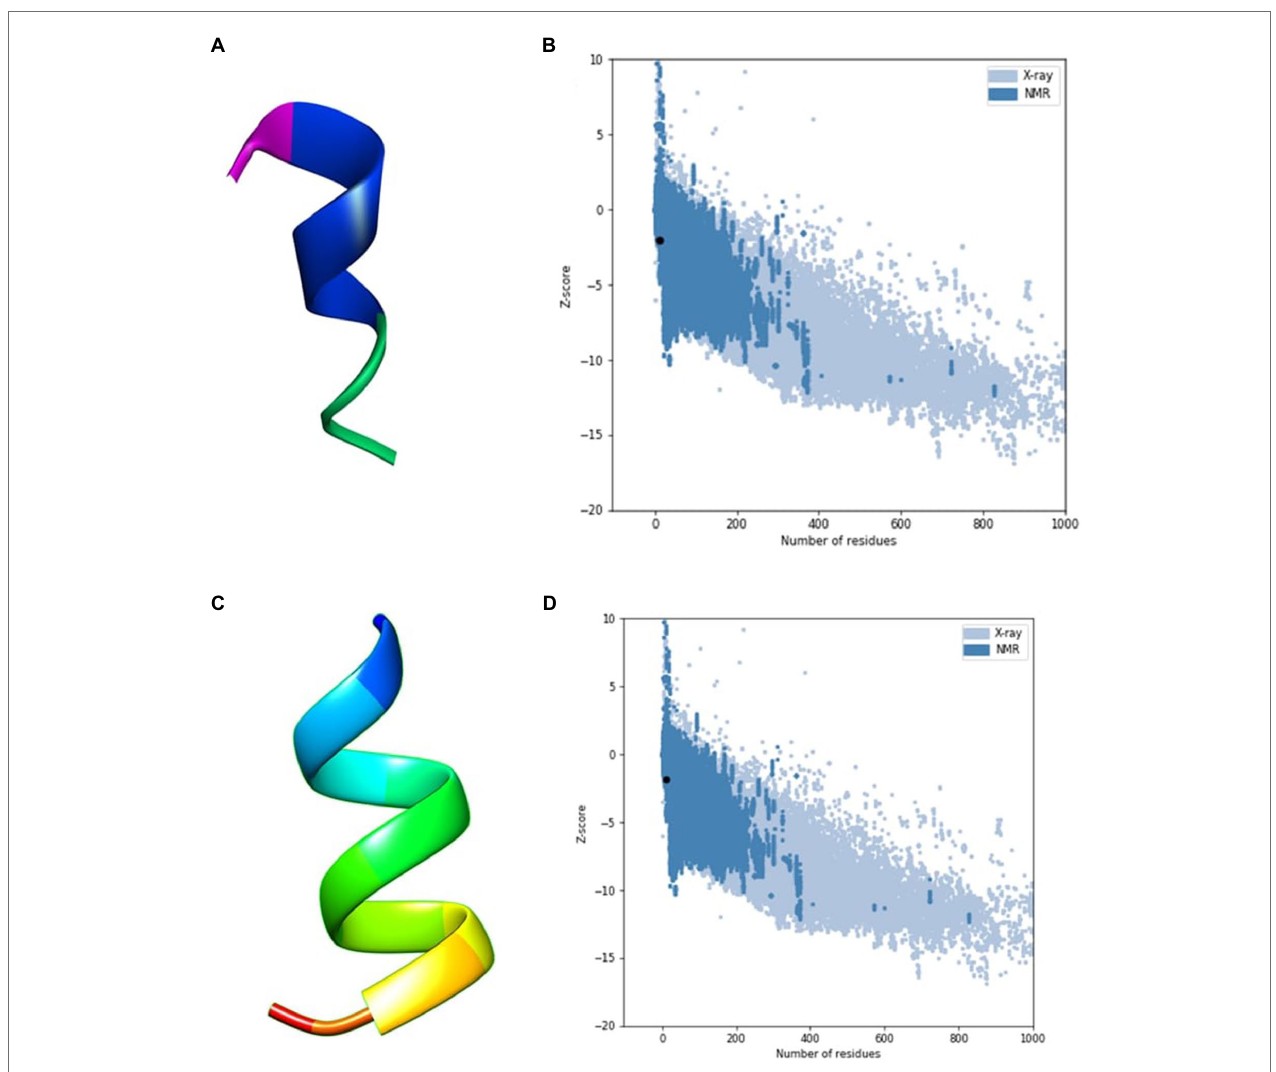
FIGURE 5 | AWSEM and PEP-FOLD predicted peptide 3D structures of ACAP-I together with respective ProSA validation plots. (A) AWSEM-modeled ACAP-I predicted 3D structure, (B) AWSEM modeled ACAP-I ProSA z -score, (C) PEP-FOLD-modeled ACAP-I 3D structure, (D) PEP-FOLD-modeled ACAP-I ProSA z - score. AWSEM modeled ACAP-I and PEP-FOLD-modeled ACAP-I peptide had z-scores of − 1.99 and − 1.85, respectively, and were within the normal z -score of experimentally validated